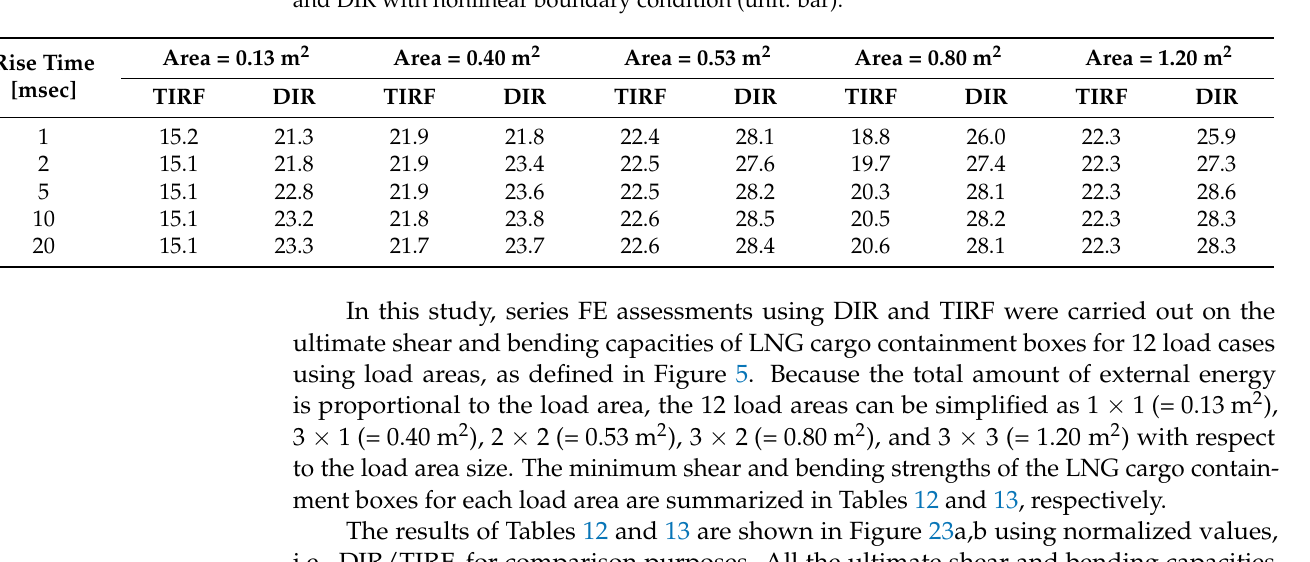
Table 13. Ultimate dynamic bending capacities of Model 3 using TIRF with linear boundary condition and DIR with nonlinear boundary condition (unit: bar).